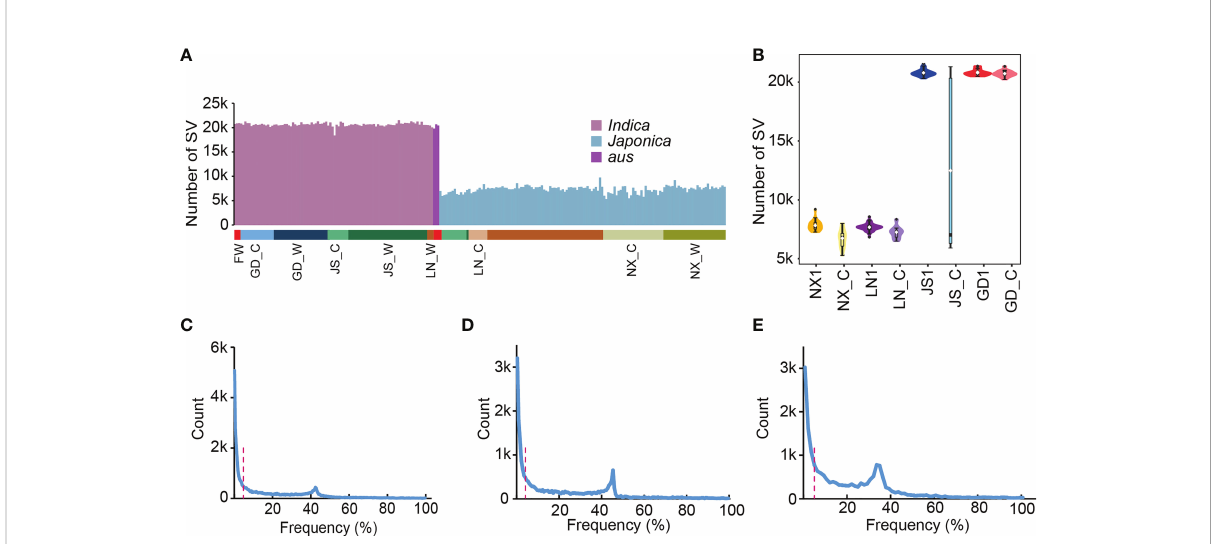
FIGURE 2 The statistics of SVs ’ number and frequency. (A) The statistics of SVs ’ number in 238 rice materials, which contains 162 weedy and 76 locally cultivated rice. LN for Liaoning, NX for Ningxia, JS for Jiangsu, GD for Guangdong and FW for weedy rice sampled outside of China. (B) The number of SVs in the four weedy rice subpopulations (NX1, LN1, JS1 and GD1) and the corresponding local cultivated rice. (C-E) Frequency of SVs in 238 rice materials (C) , 162 weedy rice (D) , and 76 local cultivated rice (E) . The red dashed line represents a frequency of 5%.